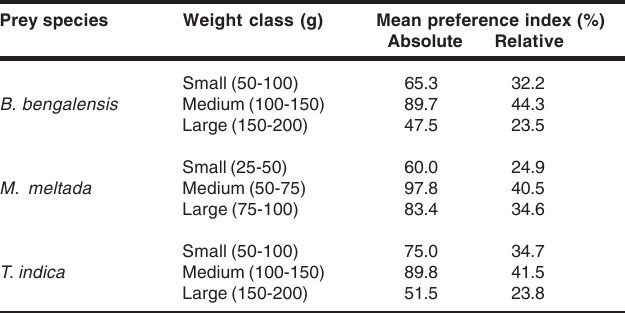
Table 3. Preference (percent biomass consumed) of different weight classes of prey species by the Barn Owl T. alba Prey